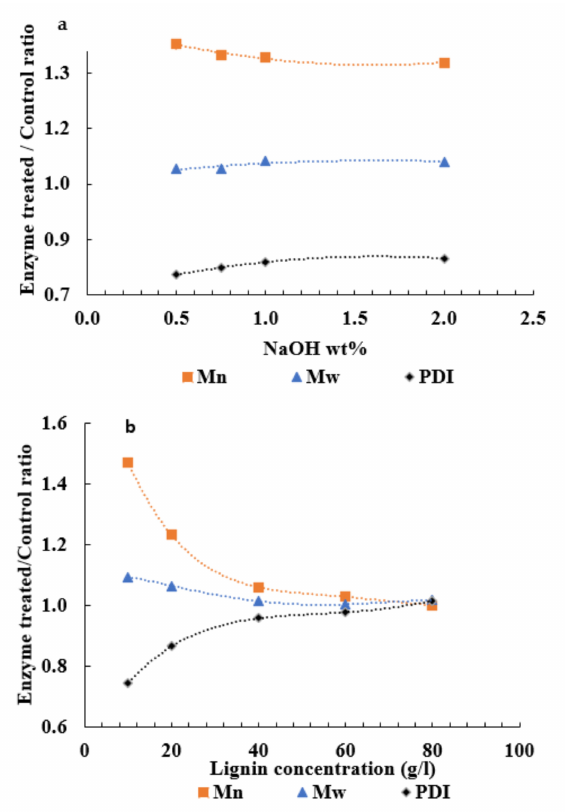
Figure 5. ( a ) ScLac inhibition at 2% (wt%) NaOH solution with 10 g/L lignin; ( b ) ScLac activity lost over 55 g/L lignin at 1% NaOH solution (pH